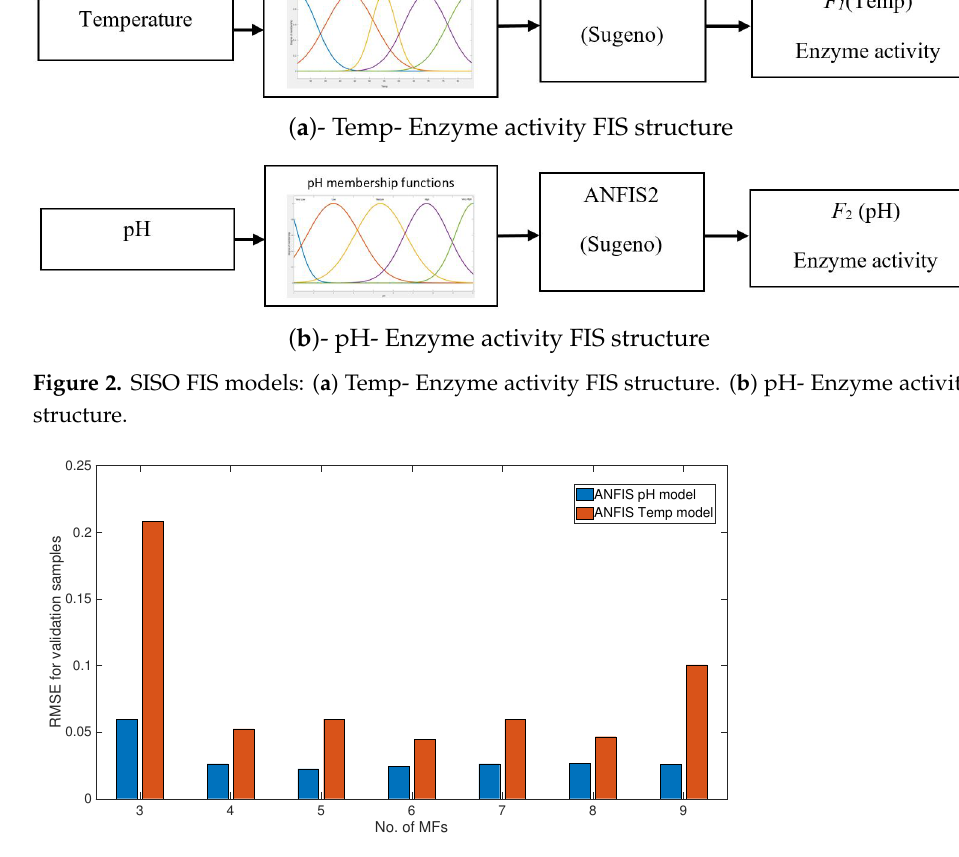
Figure 3. Effect of the number of memberships on the ANFIS models’